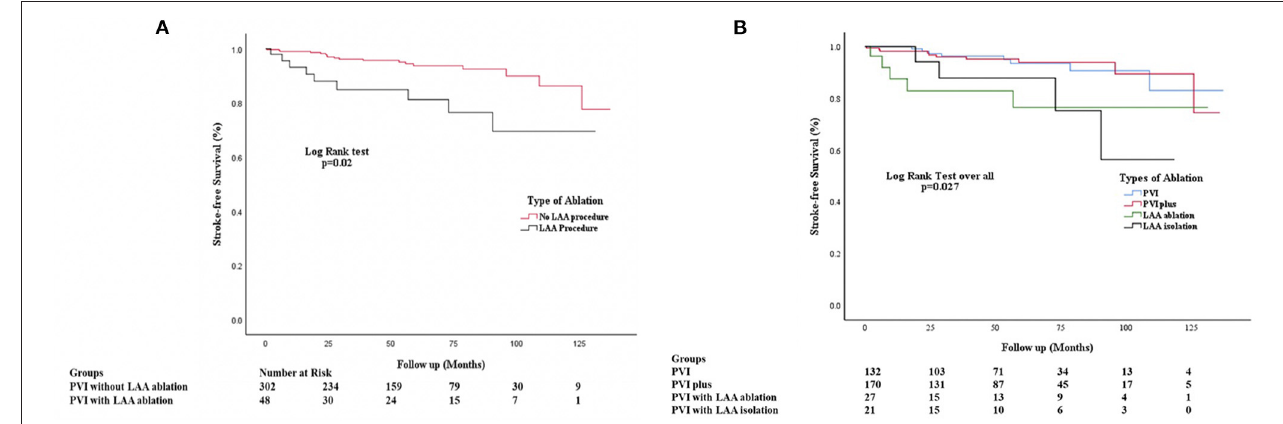
FIGURE 3 | (A) Kaplan Meier Stroke-free survival analysis comparing patients undergoing no LAA ablation vs. those who underwent LAA ablation. PVI, Pulmonary vein isolation; PVI + , Pulmonary vein isolation with ablation at additional locations except the left atrial appendage; LAA, Left Atrial Appendage. (B) Kaplan Meier Stroke-free survival analysis comparing patients undergoing no LAA ablation vs. those who underwent LAA ablation without complete isolation and with complete isolation. PVI, Pulmonary vein isolation; PVI + , Pulmonary vein isolation with ablation at additional locations except the left atrial appendage; LAA, Left Atrial Appendage; LAAa, Left Atrial appendage ablation or partial isolation; LAAi, Left atrial appendage complete isolation.